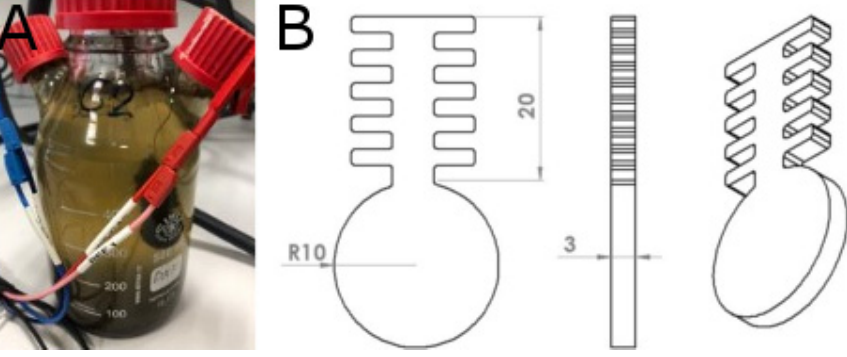
Figure 1. Bioelectrochemical reactor used in the experiments ( A ). Geometry of PLA electrodes, dimensions in mm ( B ).